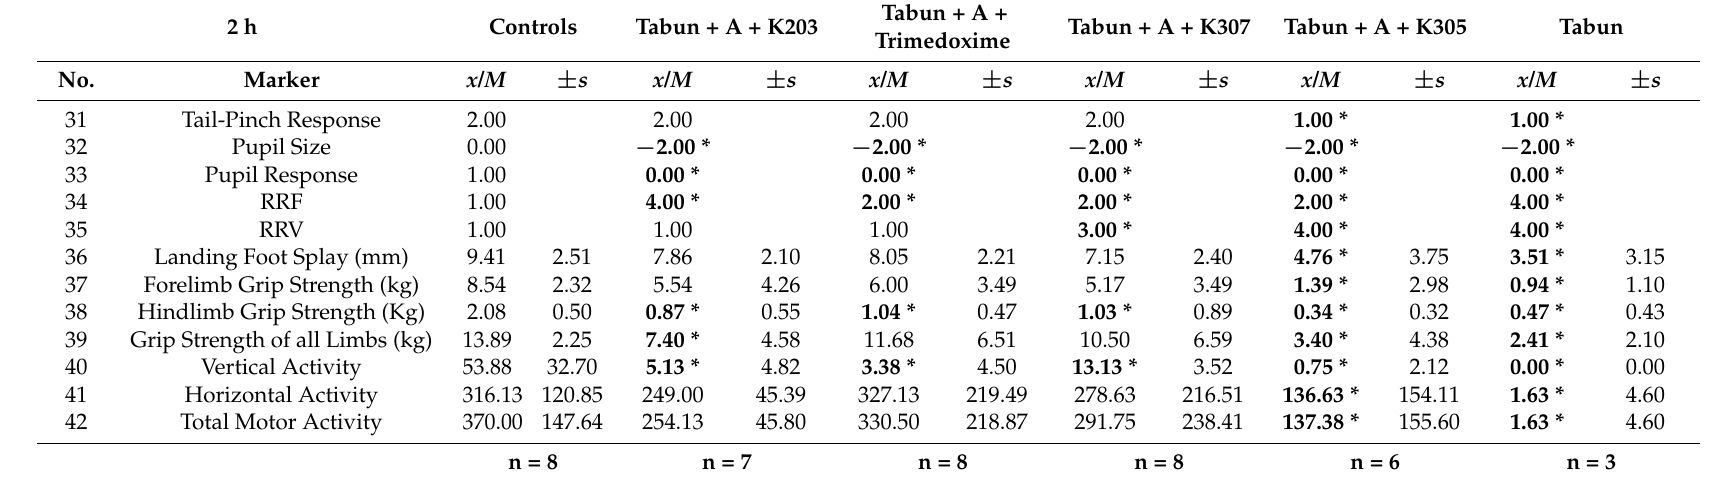
Table 2. The values of tabun-induced neurotoxic markers measured at 24 h following tabun challenge by the Functional observational battery (No. 1–11,